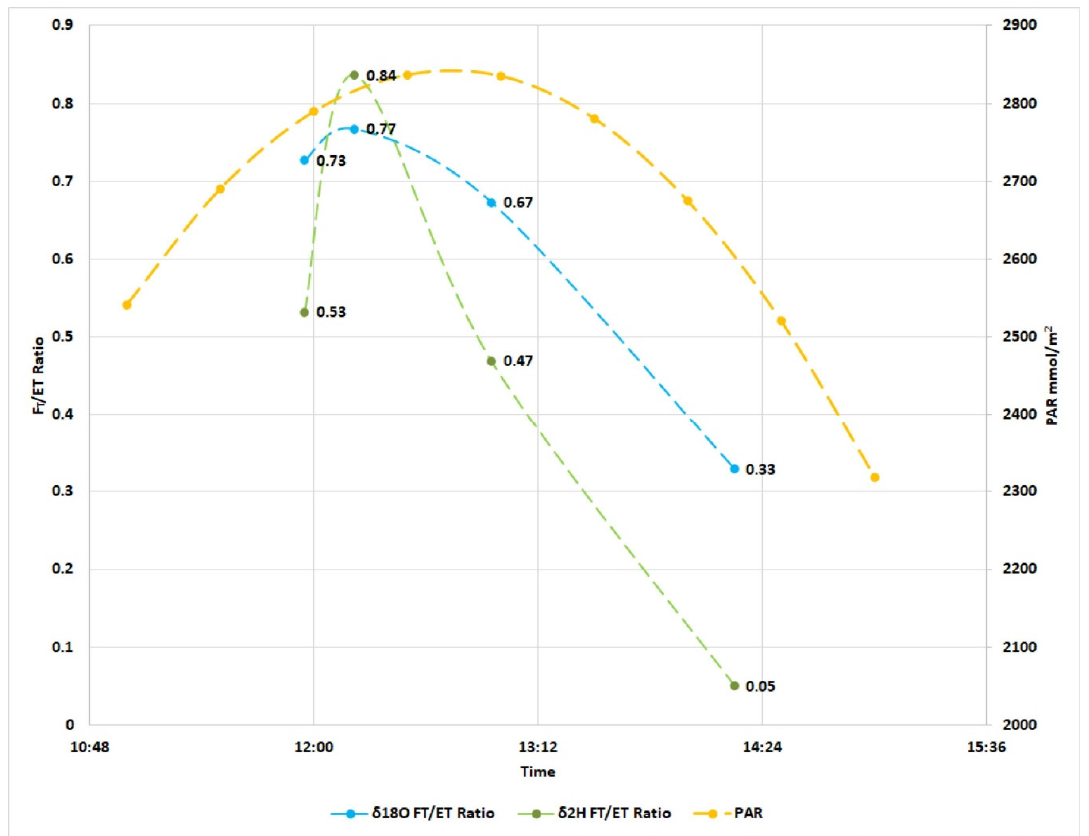
Figure 5. IMB F T /ET for δ 18 O and δ 2 H ratios of transpiration to evapotranspiration. Figure 5. IMB F / ET for δ 18 O and δ 2 H ratios of transpiration to T